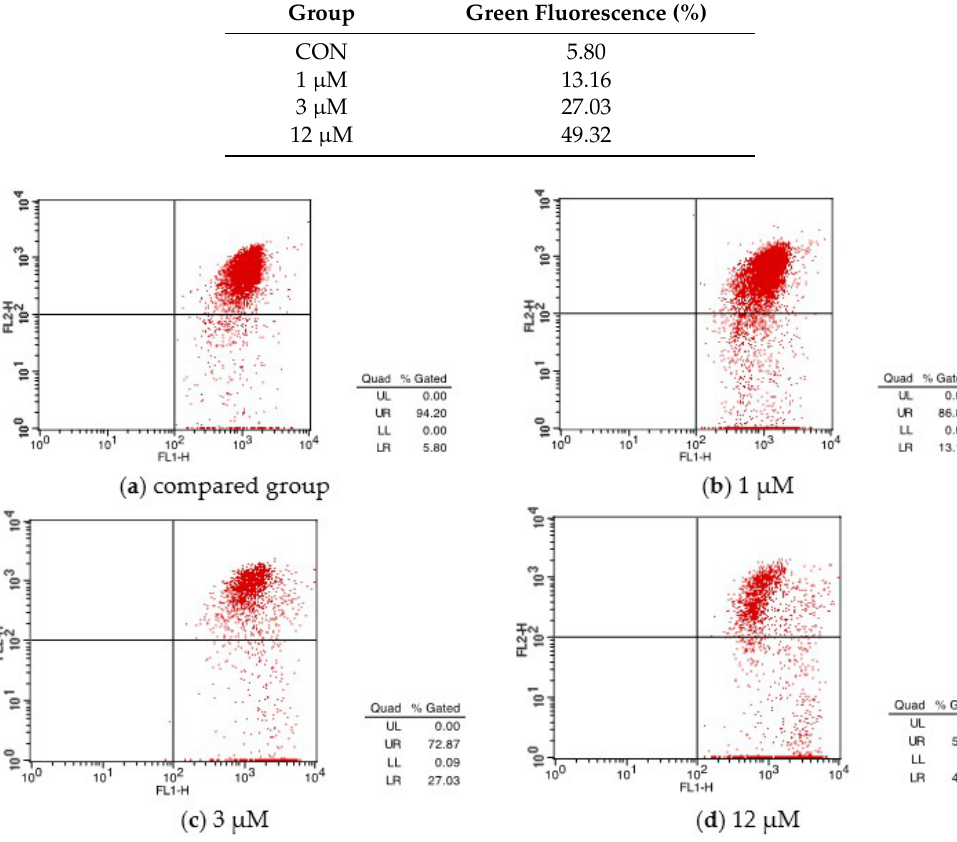
Figure 7. Different concentration of compound 4 of ( a ) compared group, ( b ) 1 µM, ( c ) 3 µM and ( d ) 12 µM on HepG2 effect of the mitochondrial membrane potential. x -axis: FL1-H; y -axis: FL2-H.